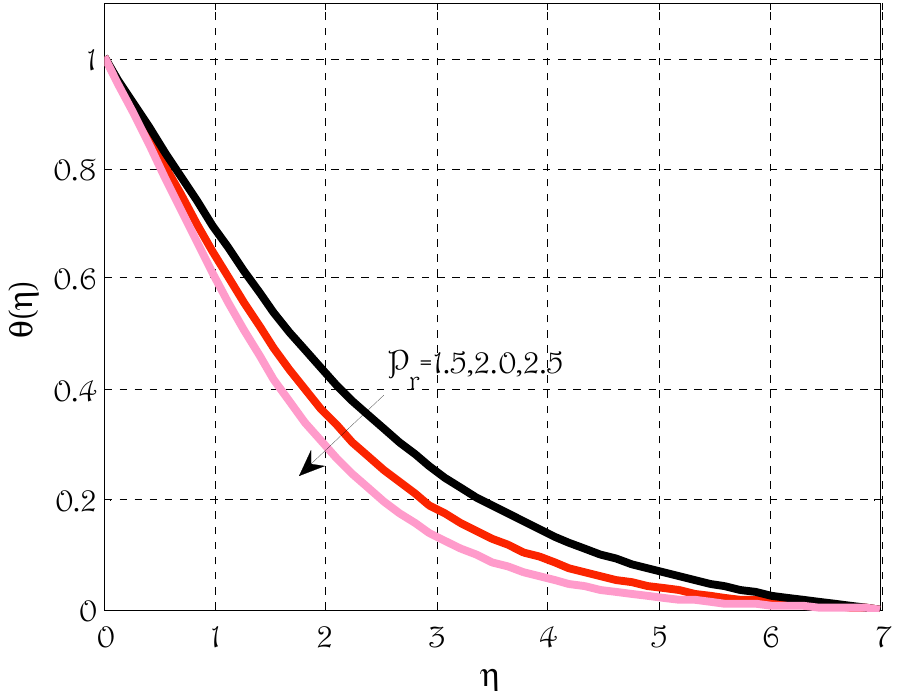
Figure 5. Effect of Prandtl number P r on temperature profile θ using k p = 0.5, M = 0.5, R d = 0.7, λ = 0.1, E c = 0.1, N b = 0.1, N t = 0.3, S c = 1.4, γ =